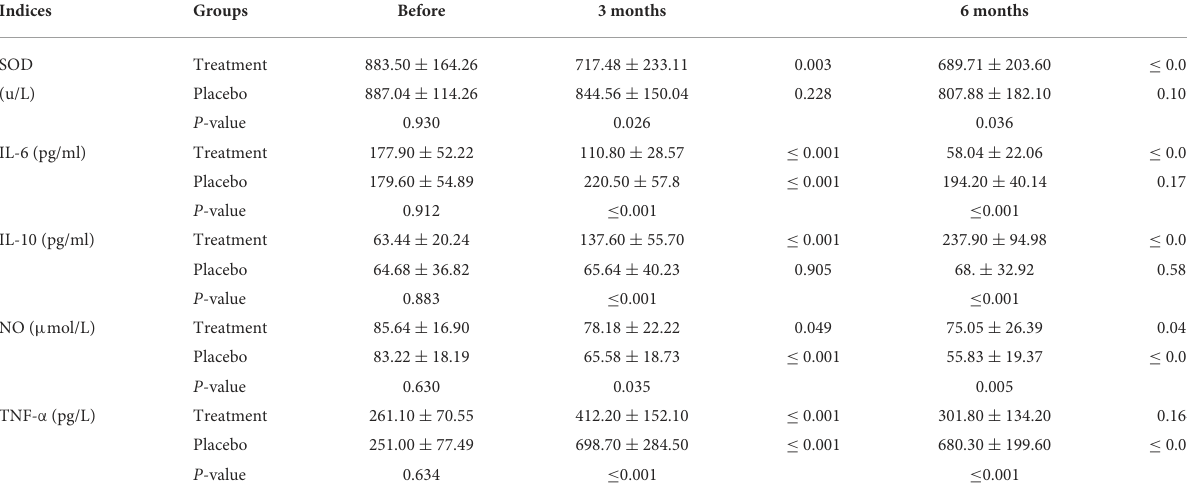
TABLE 6 Oxidative stress and inflammatory plasma